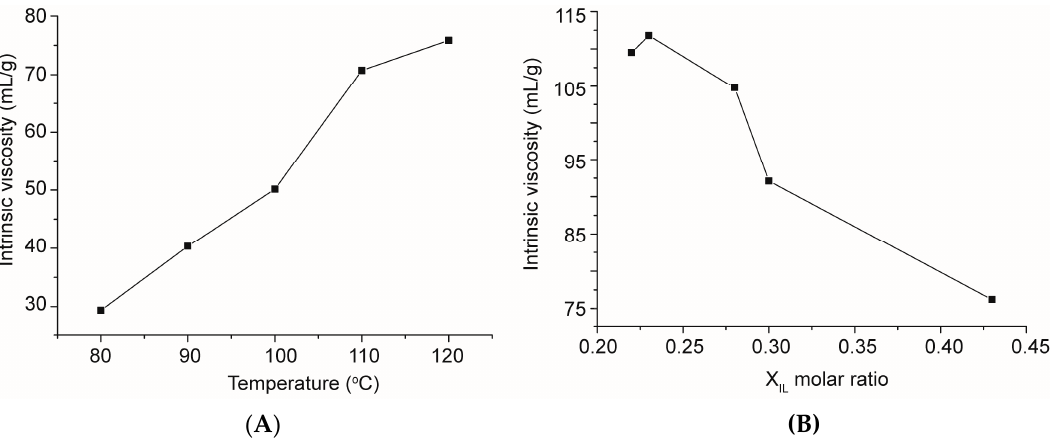
Figure 5. Intrinsic viscosity of cellulose acetates prepared at different temperatures (A) and with various molar ratios of IL (B).